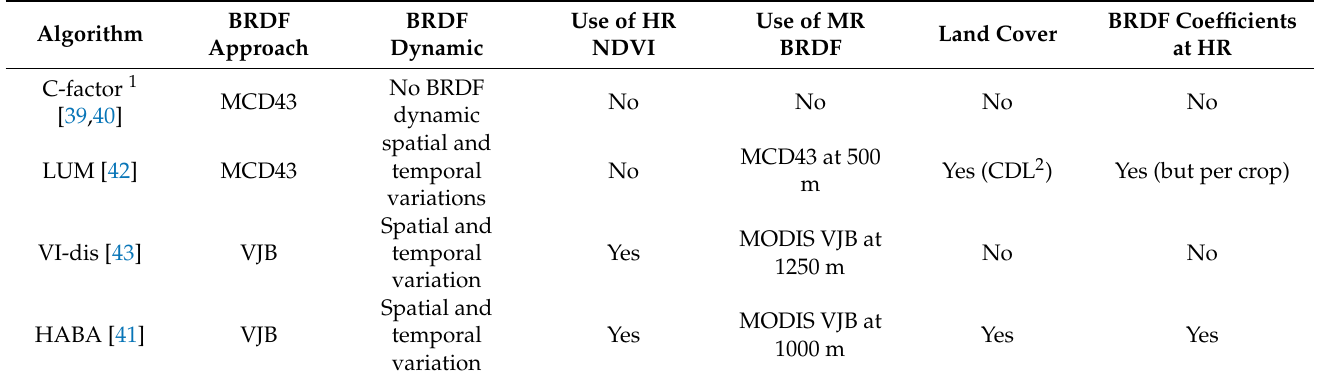
Table 2. A summary of the high-resolution BRDF-adjustment algorithms.